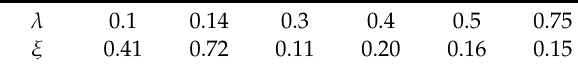
Table 7. Axis pressure influence factor value.